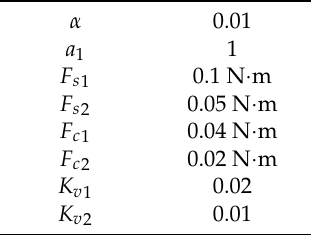
Table 2. Parameters of the Stribeck friction